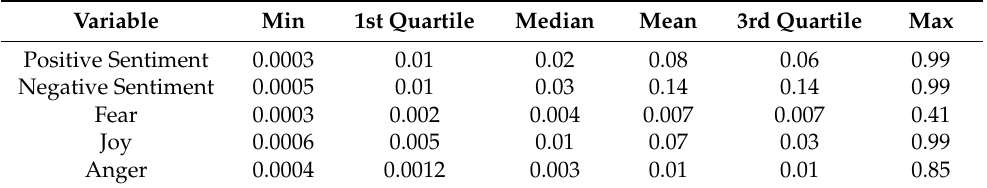
Table 1. Descriptive statistics of sentiments and